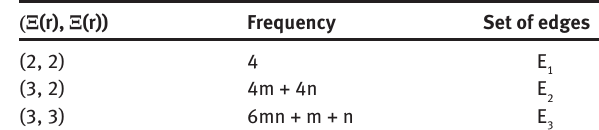
C (R)[m, n]. Table 4: Edge partition of T 2 C 4 8